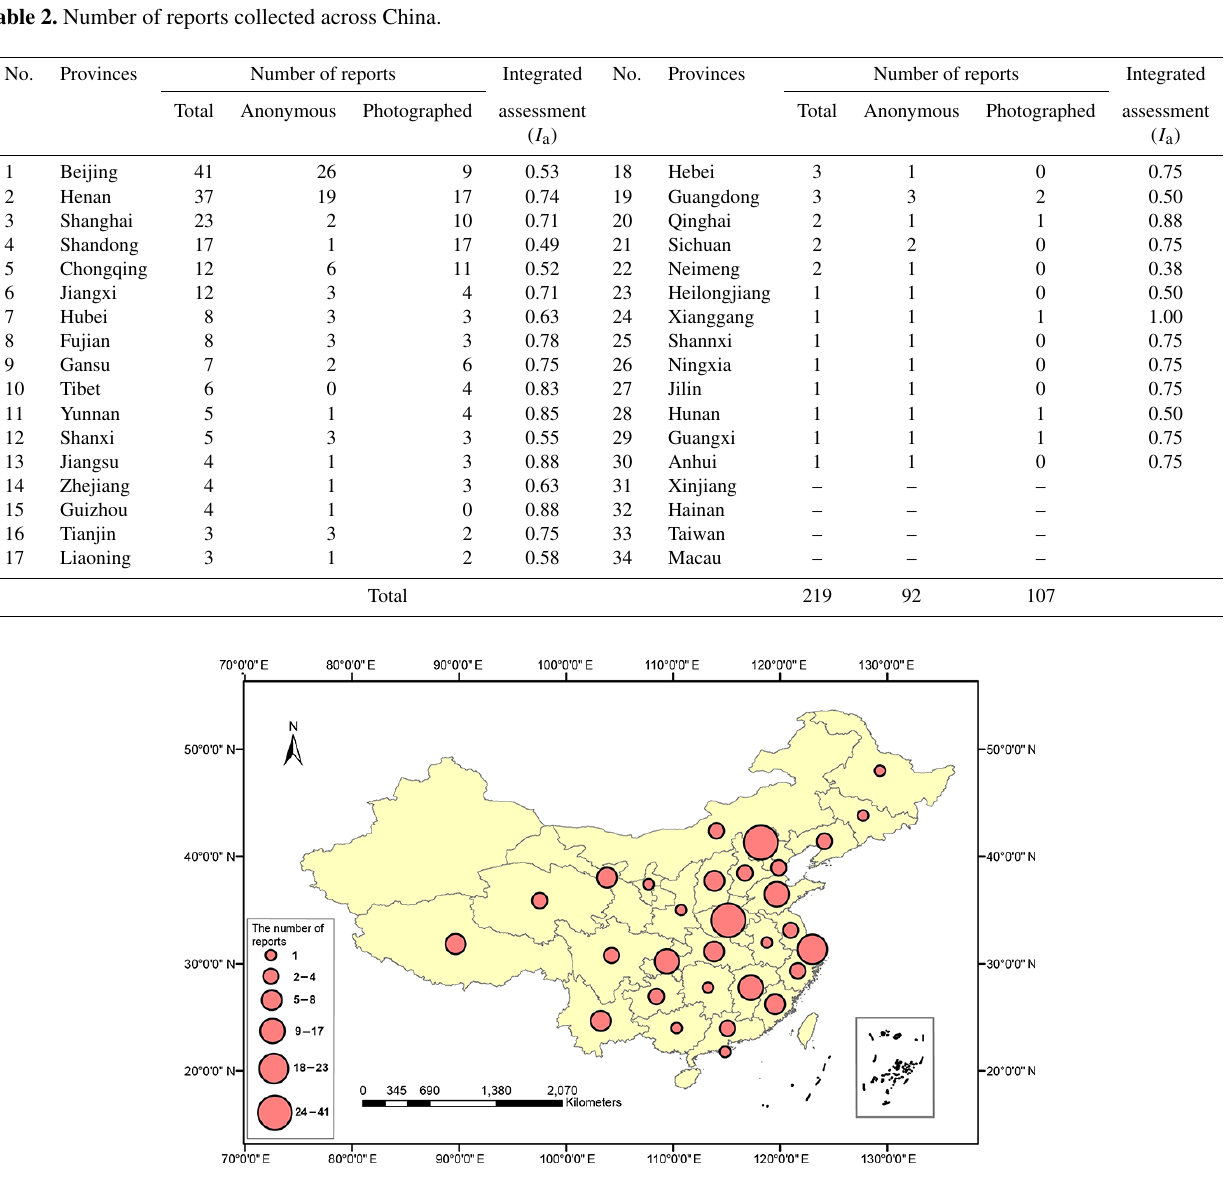
Figure 2. Distribution of reports across the provinces and cities of